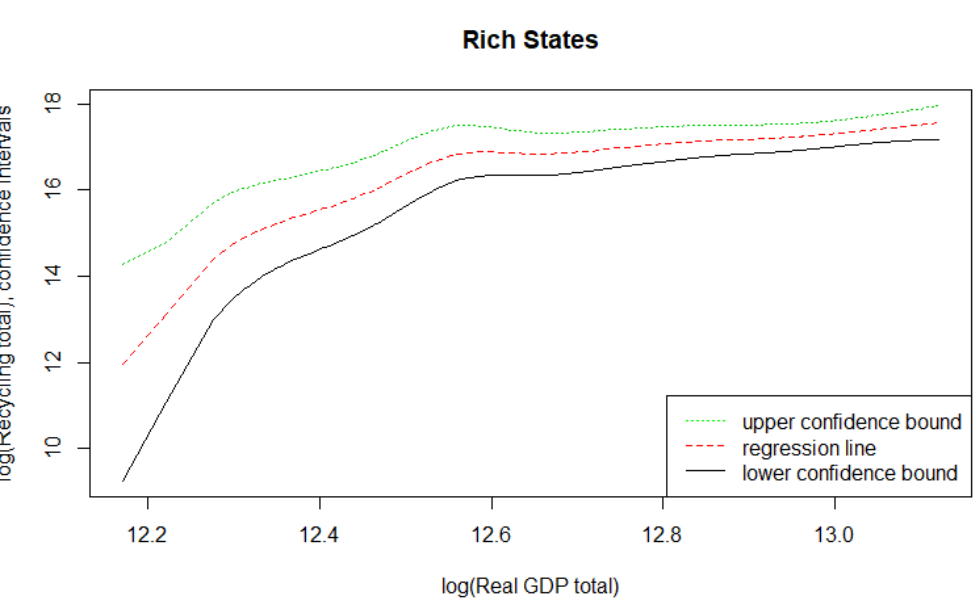
Figure 6. Relationship between log of total Recycling and log of total Real GDP for rich